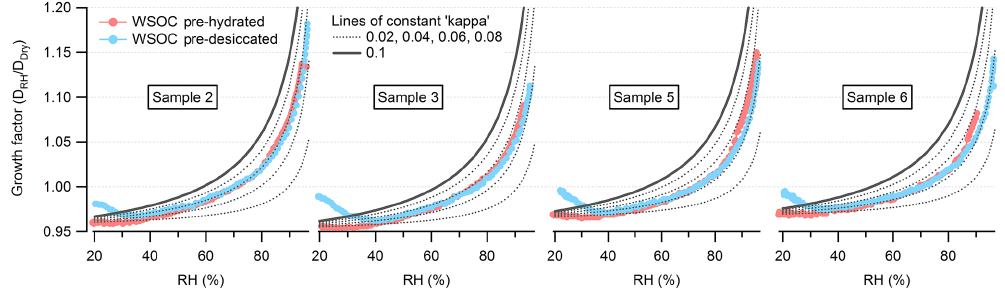
Figure 7. Hygroscopic growth measurements of WSOC samples from GRSM winter illustrating below unity growth factor and gradual collapse of pre-desiccated scans at low